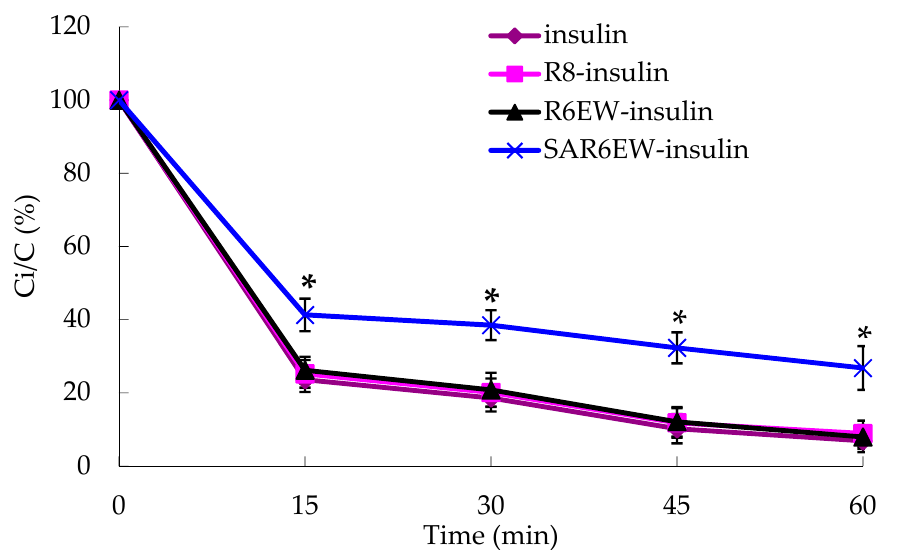
Figure 4. ( A ) Percentage of insulin remaining in the presence of trypsin at 37 °C; ( B ) Percentage of insulin remaining in the presence of α -chymotrypsin at 37 °C (mean ± SD, N = 3, *: p < 0.05, **: p < 0.01 vs. control). Ci/C (%) means the percentage of insulin remaining.